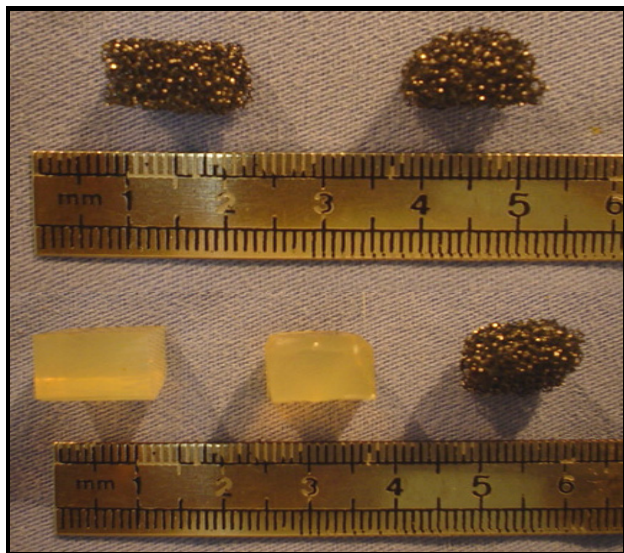
FIGURE 2 - Porous vitreous carbon and silicon used for implant